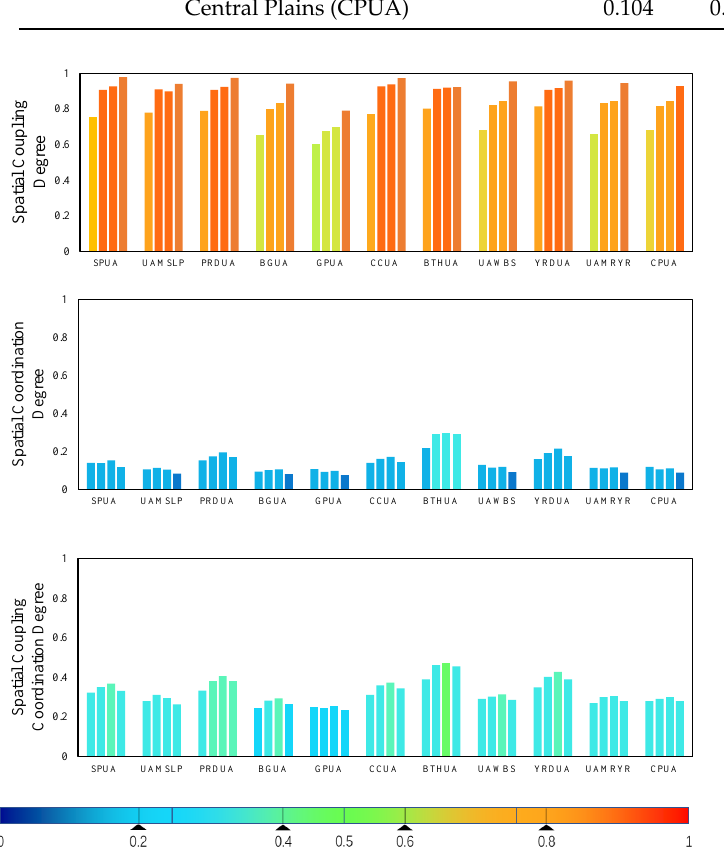
Table 3. Spatial correlation of coupling coordination degree (2014 – 2017).